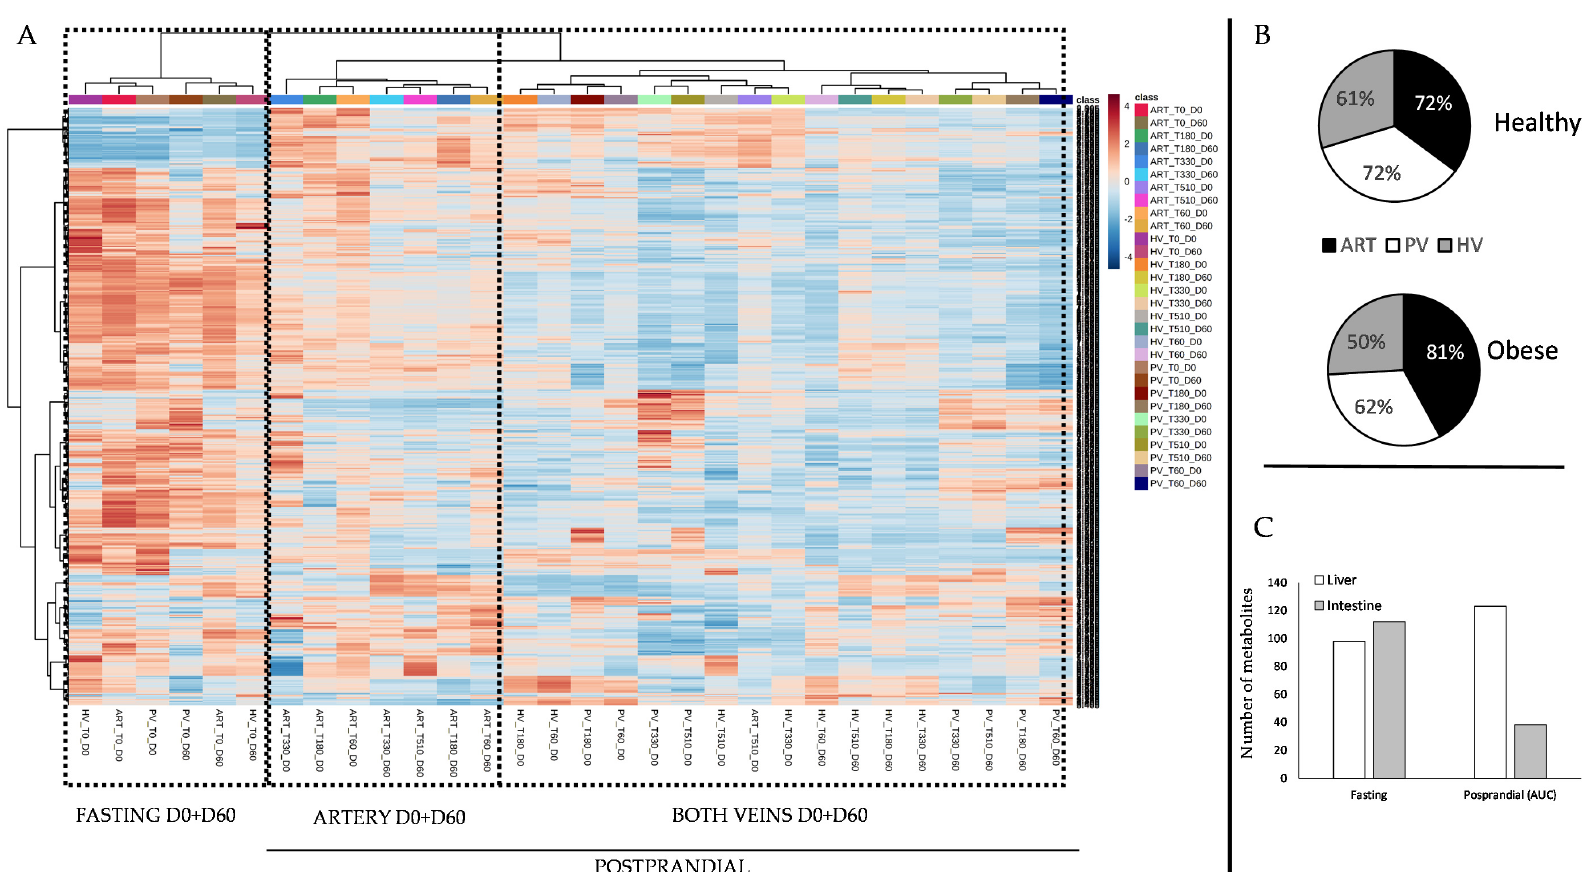
Figure 1. ( A ) Heatmap with hierarchical clustering (Euclidian distance and ward aggregation) of significant metabolic features (at least one point di ff erent from the fasting condition). Lowest ion intensity is shown in bleu while maximum intensity is shown in red. ART, artery; PV, portal vein; HV, hepatic vein. ( B ) percentage of metabolites postprandially di ff erent (at least one postprandial point di ff erent from fasting) between the healthy and the obese animals. ( C ) Number of metabolites di ff erentially exchanged across the liver and the intestine between the obese and healthy animals in the fasting and postprandial states (Area Under the Curve